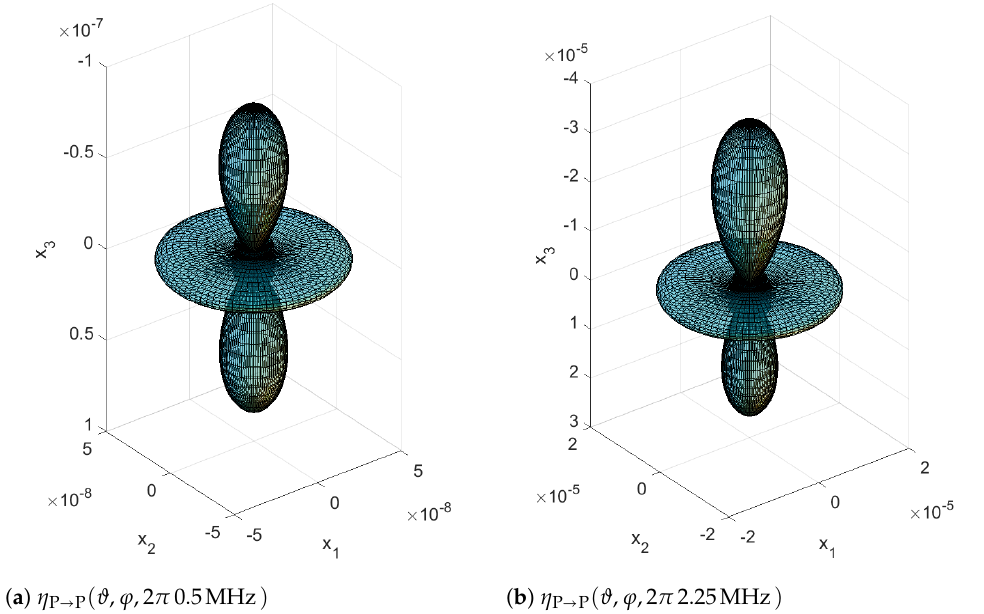
( ϑ , ϕ ,2 π f ) (in mm − 3 ) for a single scatterer of size Figure 13. Spatial scattering function η P P (cid:1) d eff = 329 µm, testing frequency ( a ) f = 0.5 MHz, d eff π f / v α = 0.15 and ( b ) f = 2.25 MHz, d eff π f / v α = 0.68, respectively. Thus, according to Equation (16), for f = 2.25, we are in the stochastic